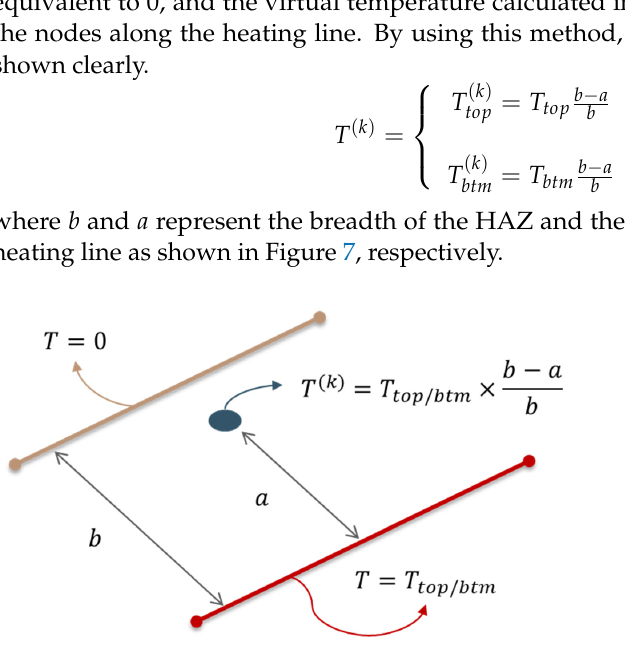
Figure 7. Virtual temperature for irregular mesh.